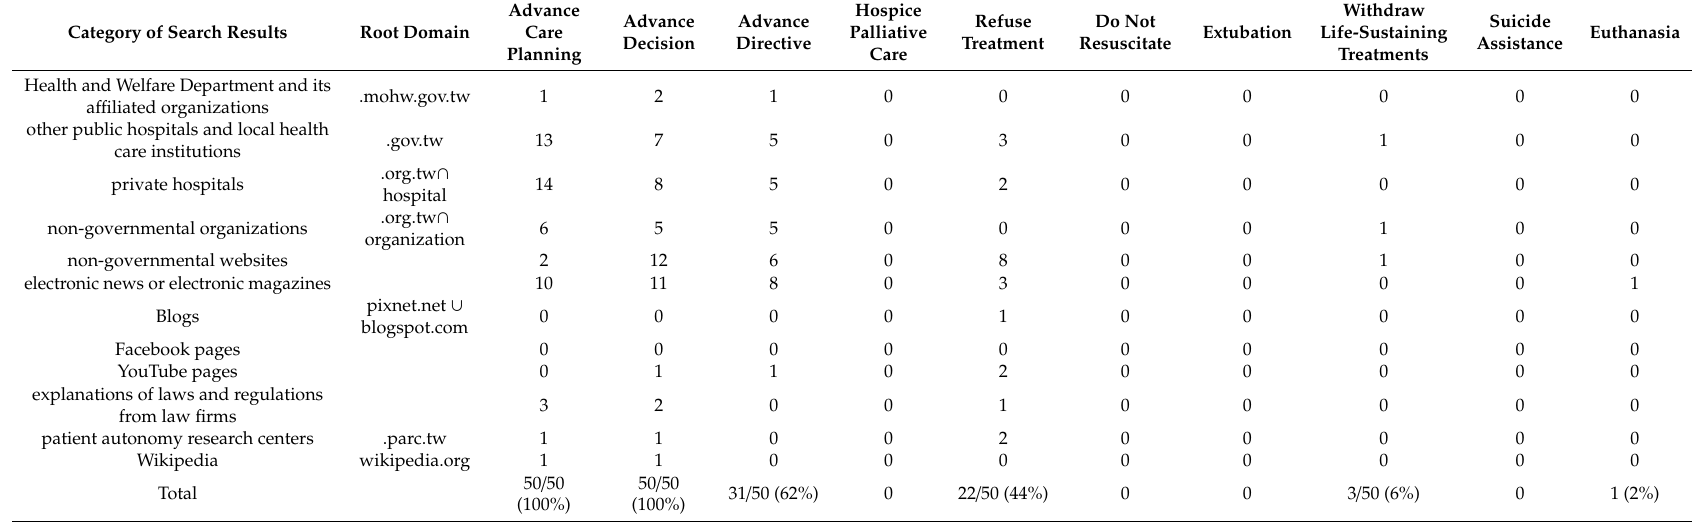
Table 2. The number of search results for each of the di ff erent terms that were related to the Patient Autonomy Act when searching with the Google search engine on 5 April